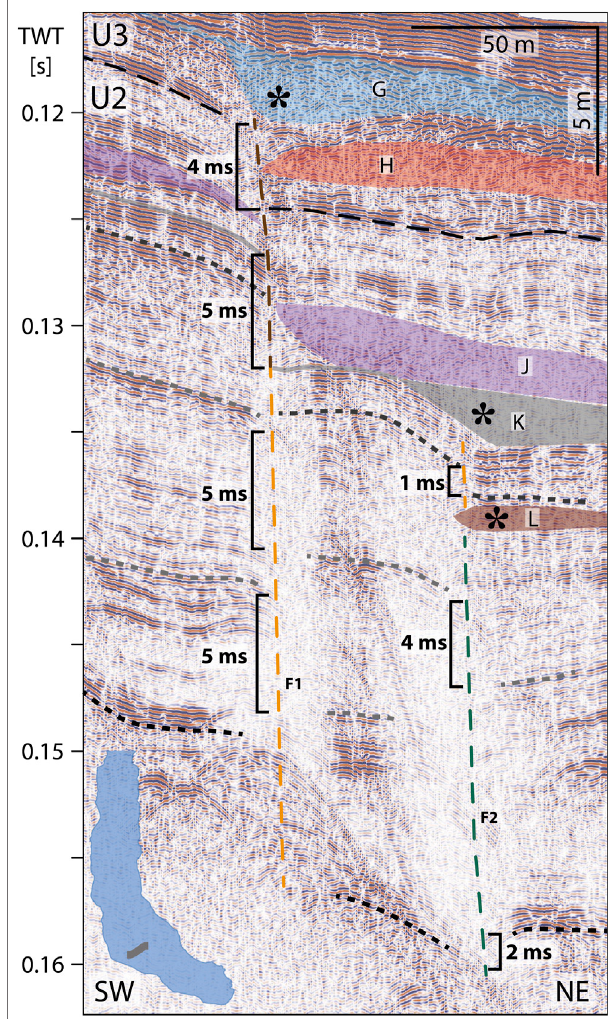
FIGURE 5 | Zoom of Figure 4A . Subaqueous faults of different generationsaredirectlyoverlainbyMTDsindicatedbystars.Faultthrow( Δ T)is measured using seismic-stratigraphic control horizons (narrow dashed lines). Faultsarecoloredbasedontheirupperterminationinfaultinggeneration I, II and III (color code in Figure 4A ). Stratigraphic control horizons are shown as narrow dashed lines. Note the fault growth sequence along both faults and the reversal of fault throw ofthe F2 fault. Map inset in lower left shows position of the pinger pro fi le.